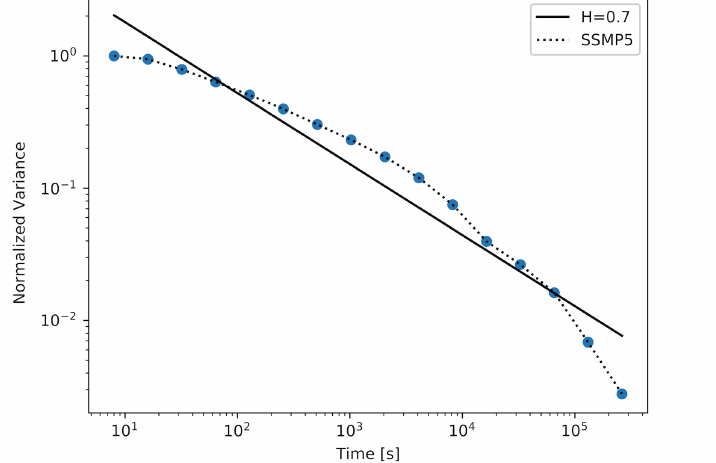
Figure 2. The aggregate variance of the sample in several time scales with the SSMP model, n =